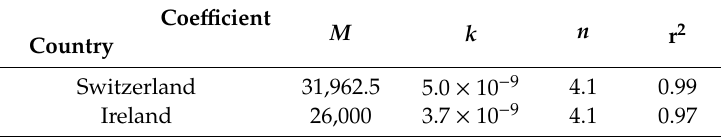
Table 3. Values of coefficients M , k , and n for Switzerland and Ireland.